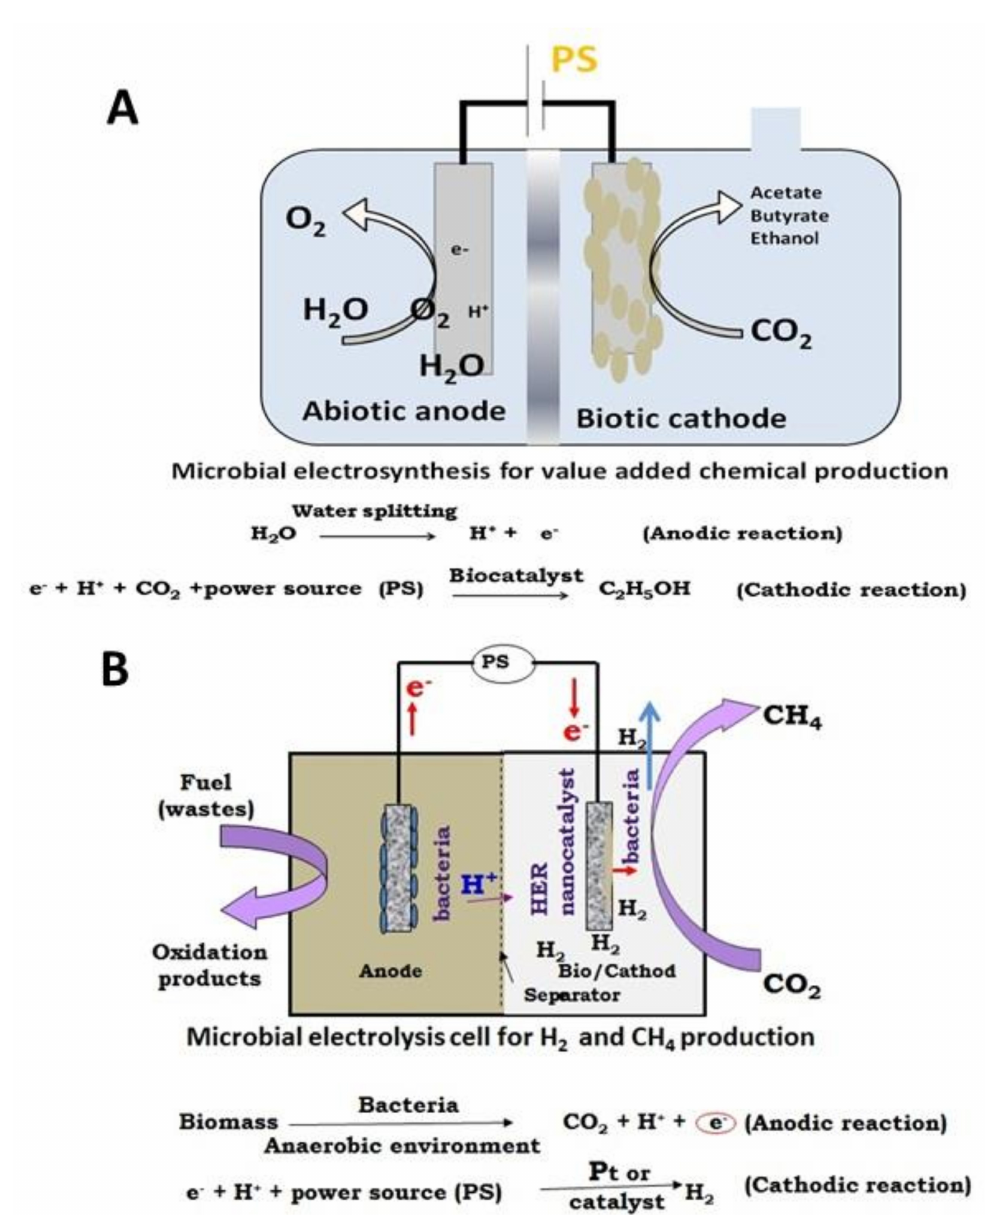
Figure 2. Diagrammatic representation of di ff erent electrofermentation process and its operation. ( A ) Microbial electrosynthesis; ( B ) Microbial electrolysis